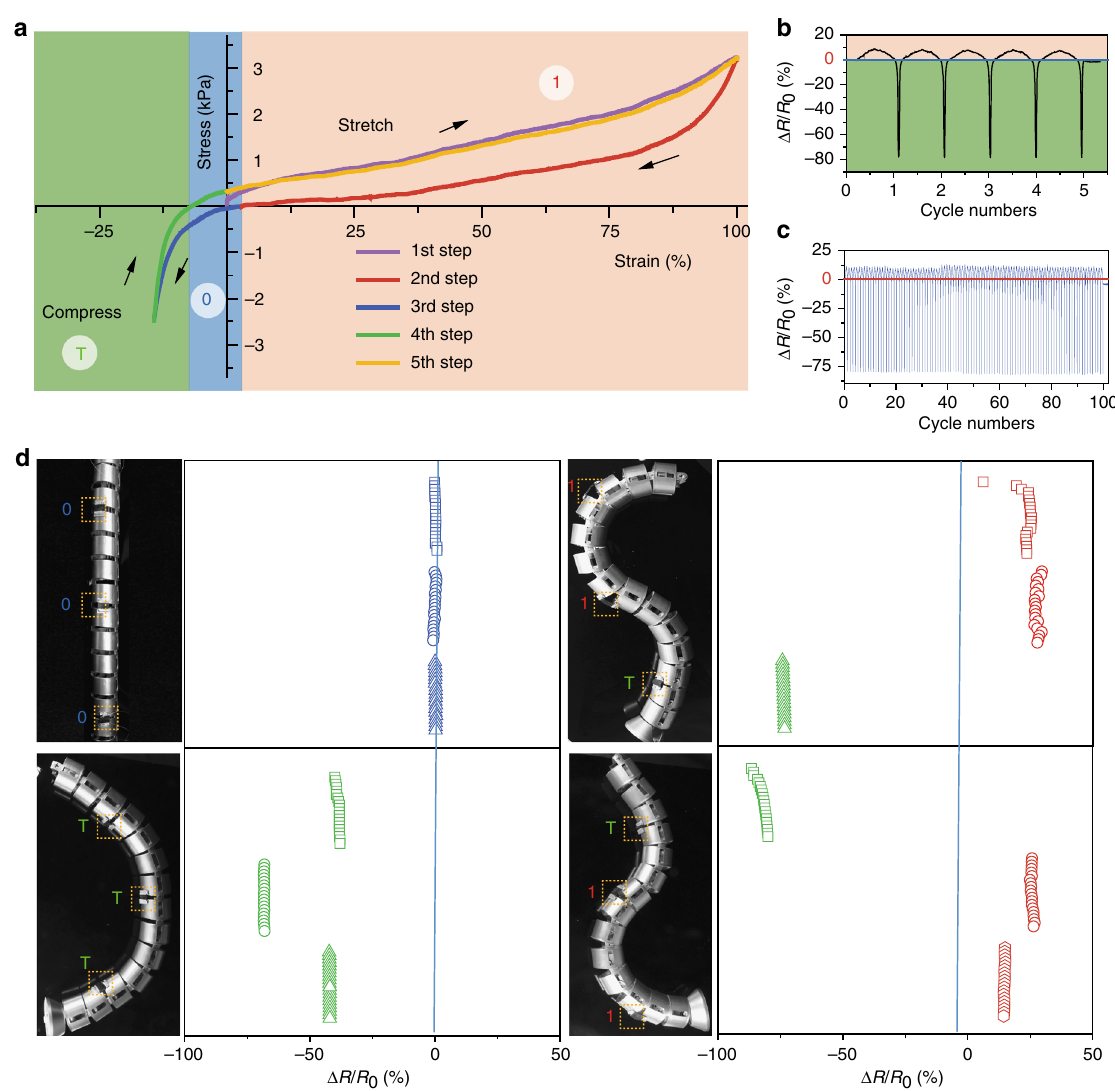
Fig. 7 The bCAs as logic identi fi cation strain sensors. a Stress-strain curves of bCAs with 30 wt% MWNTs in a full strain range from + 100% to − 14%. b , c The evolution of resistance in the fi rst 5 cycles ( b ) and 100 cycles ( c ) of bCAs. d A three-localized bCA strain sensor array works as the logic sensor to identify the movement and con fi guration of a snake-like